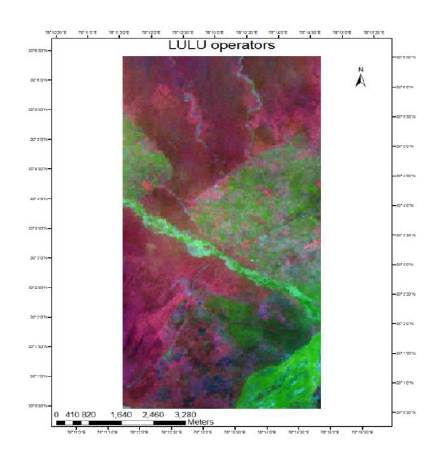
Figure 4: Fused Image of LULU